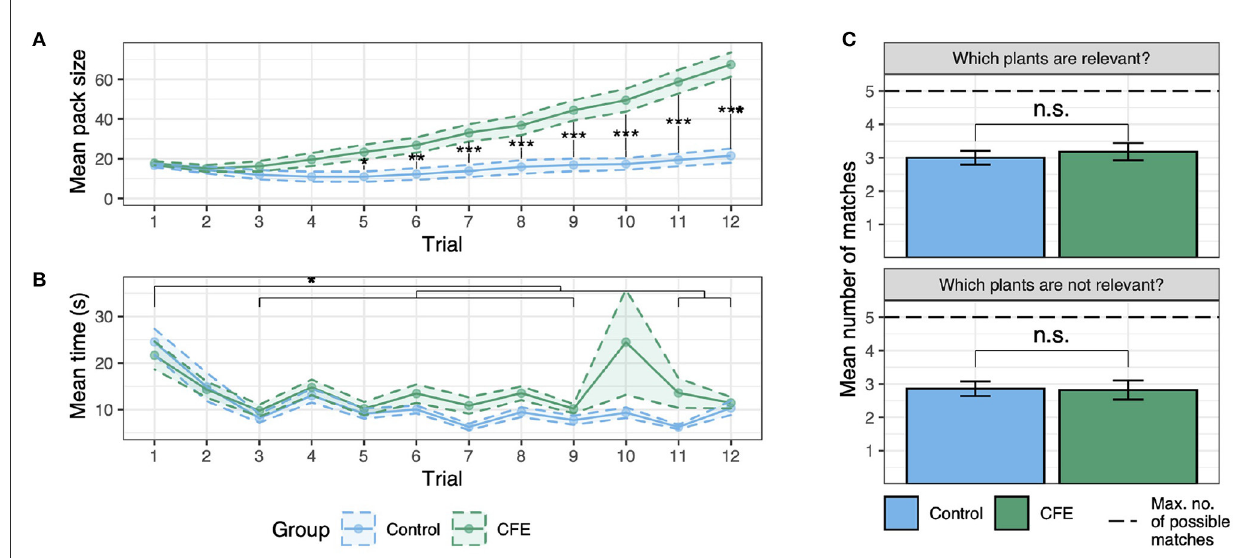
FIGURE7 Experiment 2: Development of (A) mean pack size per group by trial, (B) mean decision time per group by trial, and (C) mean number of matches between user judgments and ground truth for survey items assessing relevant plants and irrelevant plants, respectively. Shaded areas in (A) and (B) , and error bars in (C) denote the standard error of the mean. Asterisks denote statistical significance with ∗ p < 0.05, ∗∗ p < 0.01, and ∗∗∗ p < 0.001, respectively, and n.s., not statistically significant (i.e., p >